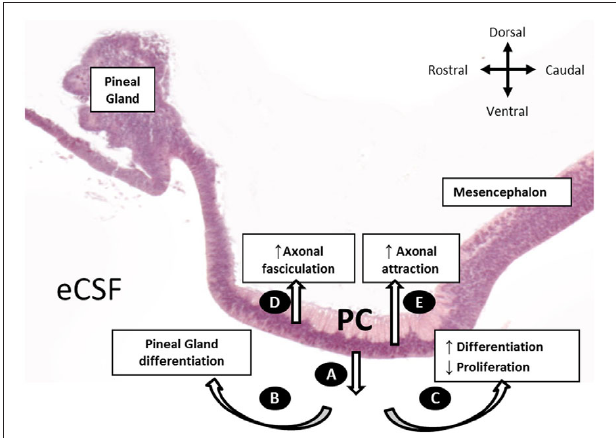
FIGURE 9 | Schematic representation of the SCO-spondin secretory routes and their respective roles, as proposed in the present work. (A) Apical secretion of SCO-spondin to the eCSF. (B) Rostral spreading of SCO-spondin promoting pineal gland differentiation. (C) Caudal spreading of SCO-spondin towards the mesencephalic cavity, inducing neurodifferentiation at the expense of proliferation. (D) Basal secretion of SCO-spondin by the rostral SCO cells, promoting axonal fasciculation of the PC. (E) Basal secretion of SCO by the caudal SCO cells promoting incorporation of new axons to the